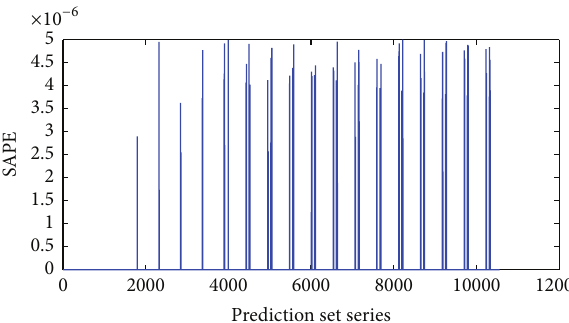
Figure 7: Multistep prediction results of Mackey-Glass time series: the SAPE of parameter